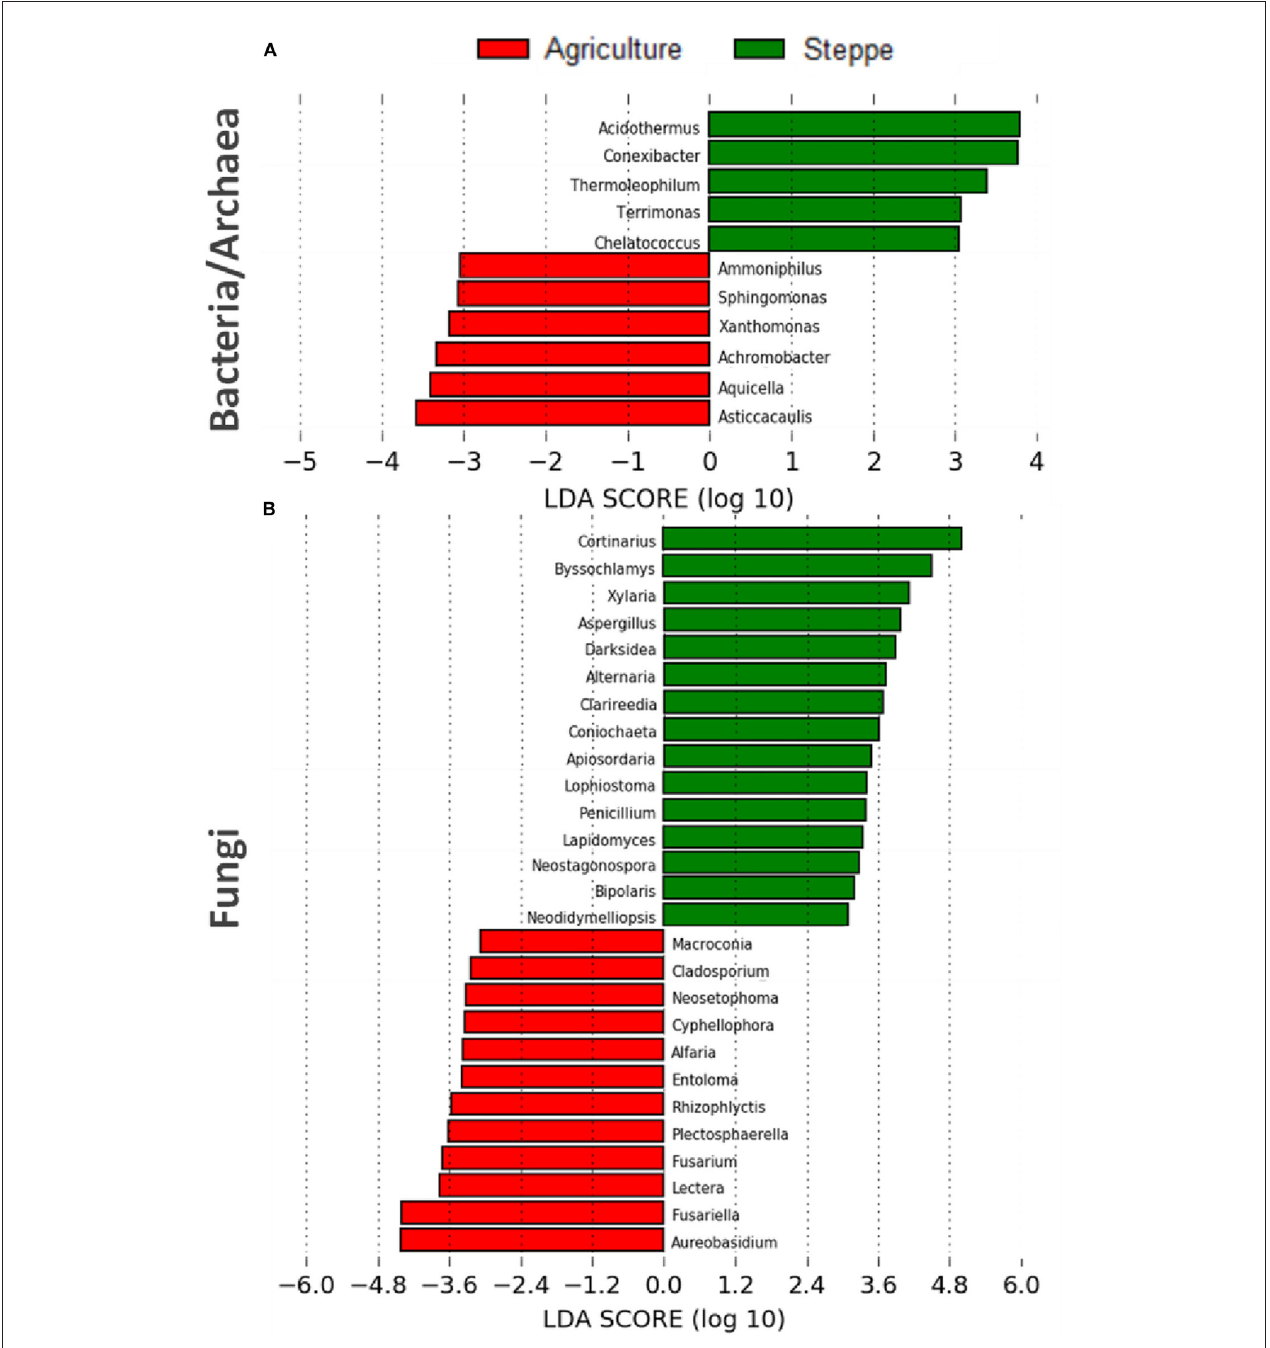
FIGURE 7 | Linear discriminant analysis effect size (LEfSe) analysis showing (A) bacterial/archaea and (B) fungal microbiota changes between the irrigated agriculture and steppe ( n =